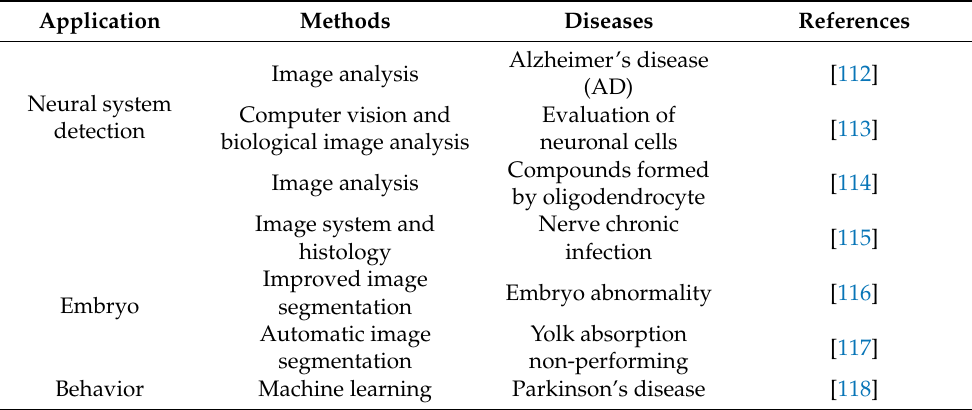
Table 4. The application of image-processing technology in researching diseases in